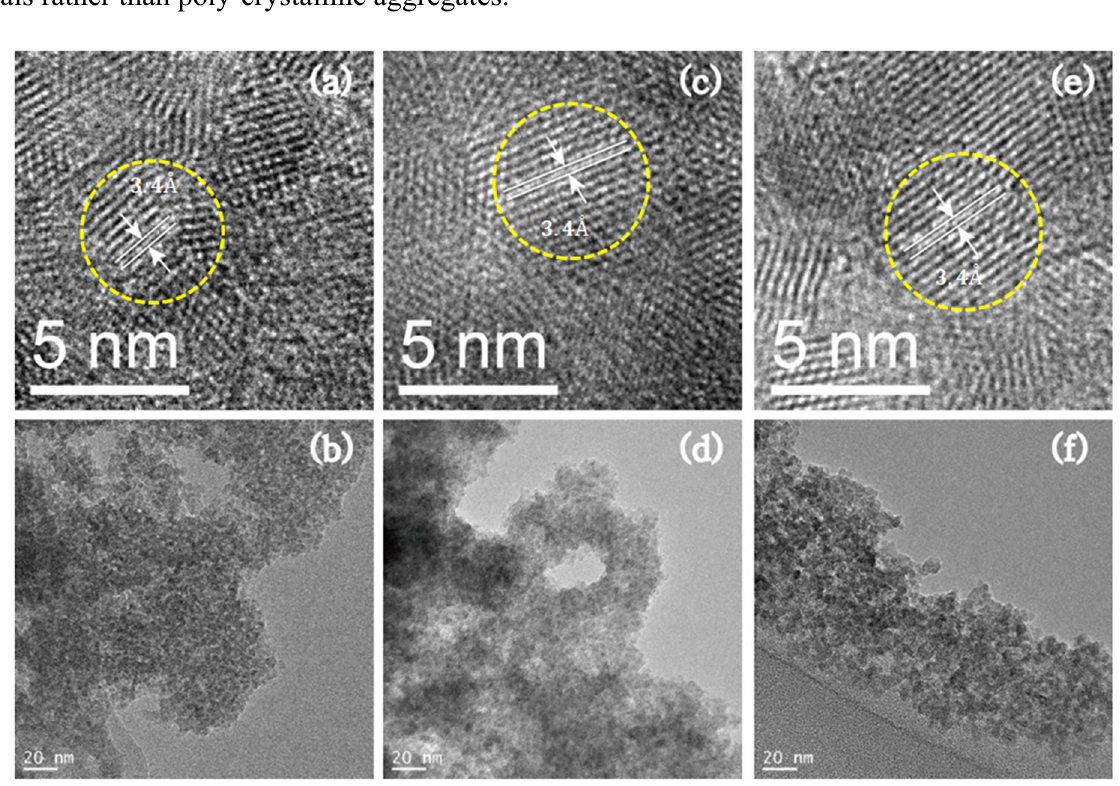
Figure 1. High-resolution transmission electron microscopy (HR-TEM) images of